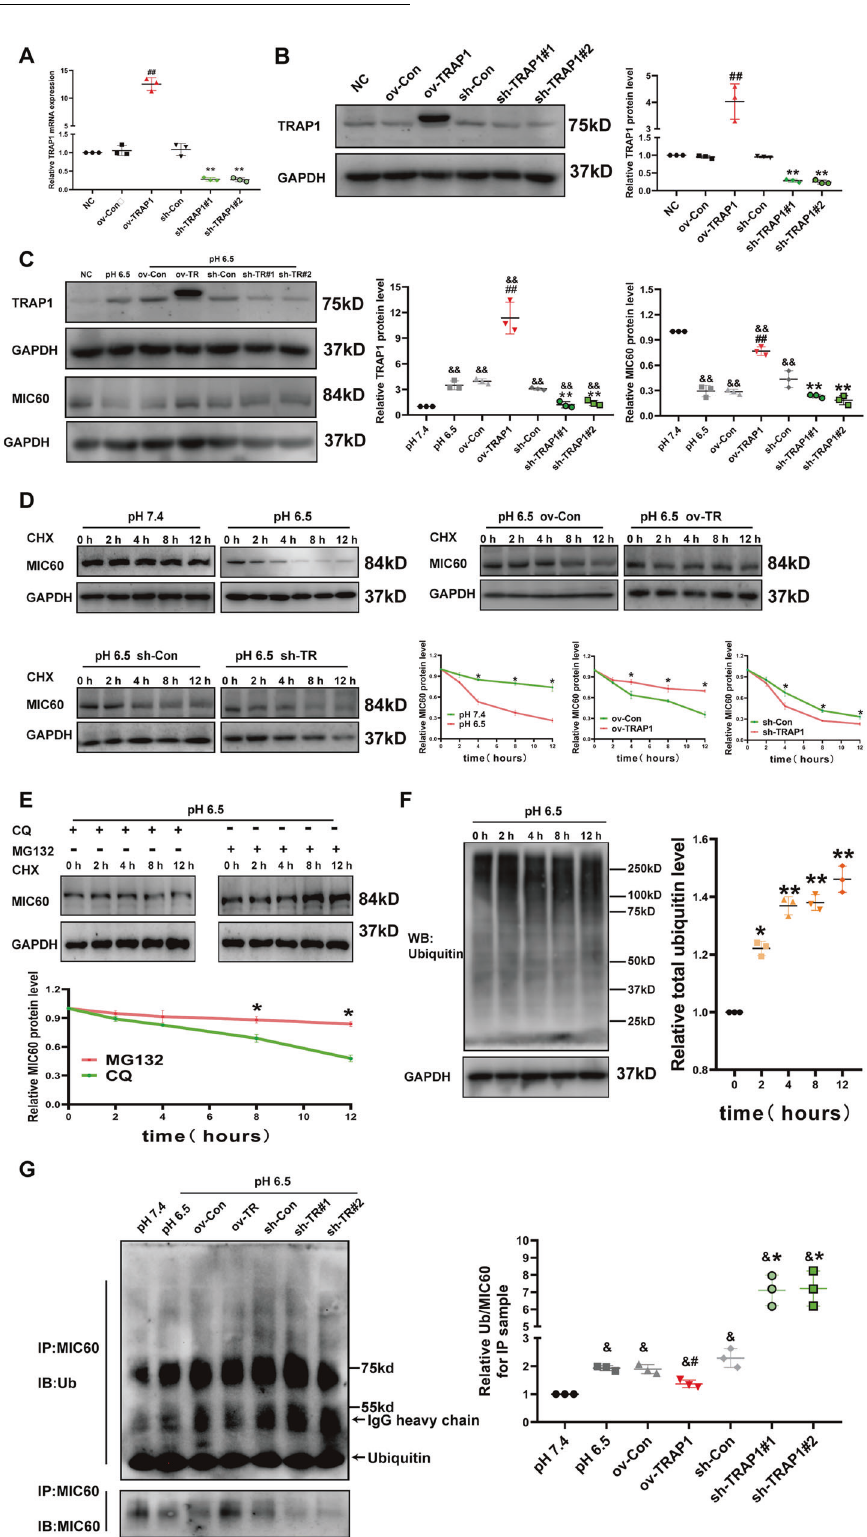
Fig. 3 TRAP1 increased MIC60 protein levels of H9C2 cells via alleviating MIC60 ubiquitin-dependent degradation in extracellular acidosis. A , B RT-qPCR and western blot were used to determine the transfection ef fi ciency of TRAP1 in H9C2 cells. C Western blot was used to detect TRAP1 or MIC60 protein levels of H9C2 cells. D , E Western blot was used to detect the degradation of MIC60 protein. F Western blot was used to detect whole cell lysate ubiquitination. G Western blot was used to detect MIC60 protein ubiquitination. CHX (cycloheximide, 20 uM) was used to inhibit protein synthesis. MG132 (10 uM) was used to inhibit proteasome. CQ (Chloroquine phosphate, 10 uM) was used to inhibit lysosomes. Data were the means ± SD from three independent experiments. Group comparisons were performed by one-way analysis of variance followed by Tukey ’ s post hoc test. && P < 0.01 vs. pH 7.4 group. ## P < 0.01 vs. ov-Con group. * P < 0.05 vs. 0 h, CQ or Con group. ** P < 0.01 vs. sh-Con or 0 h group. Cell Death Discovery (2021)